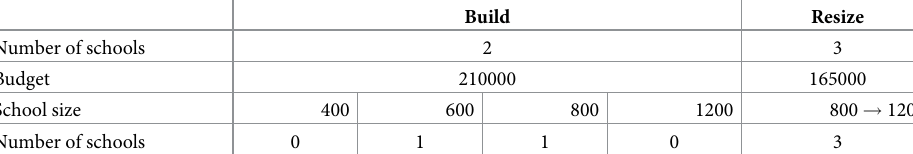
Fig 13. Coverage in 2015-2020 with new schools. https://doi.org/10.1371/journal.pone.0262520.g013 Table 3. Updates in the 2015-2020 period.